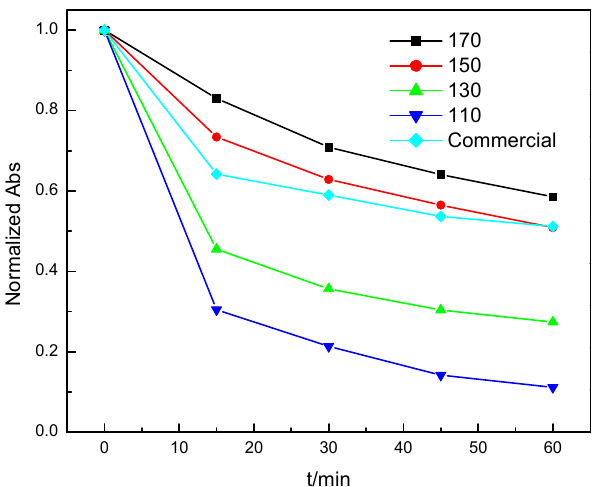
Table 2. Comparison of phenol removal with different reagents.